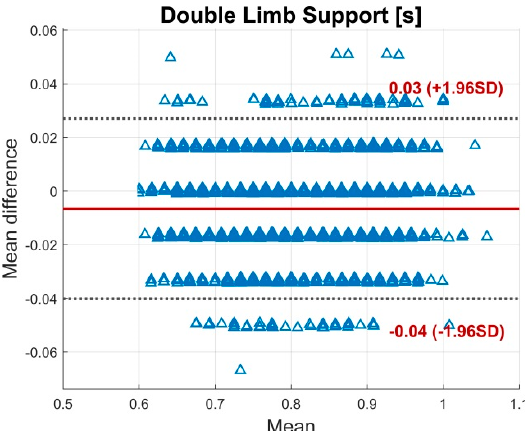
Figure A2. BA plot for the double limb support. The plot contains all calculated data points of all subjects. The solid line indicates the mean difference. The dashed lines indicate the LoA (95% CI of the mean difference).